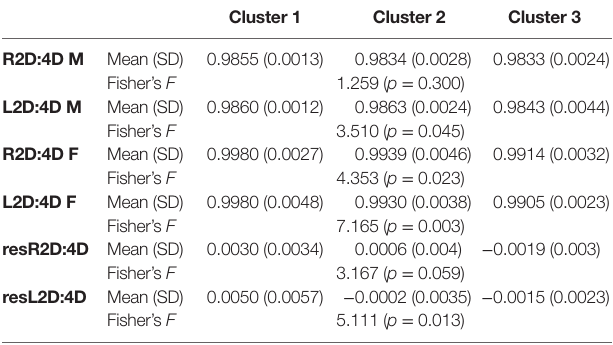
tabLe 2 | digit ratio values in each cluster – based on Manning et al.